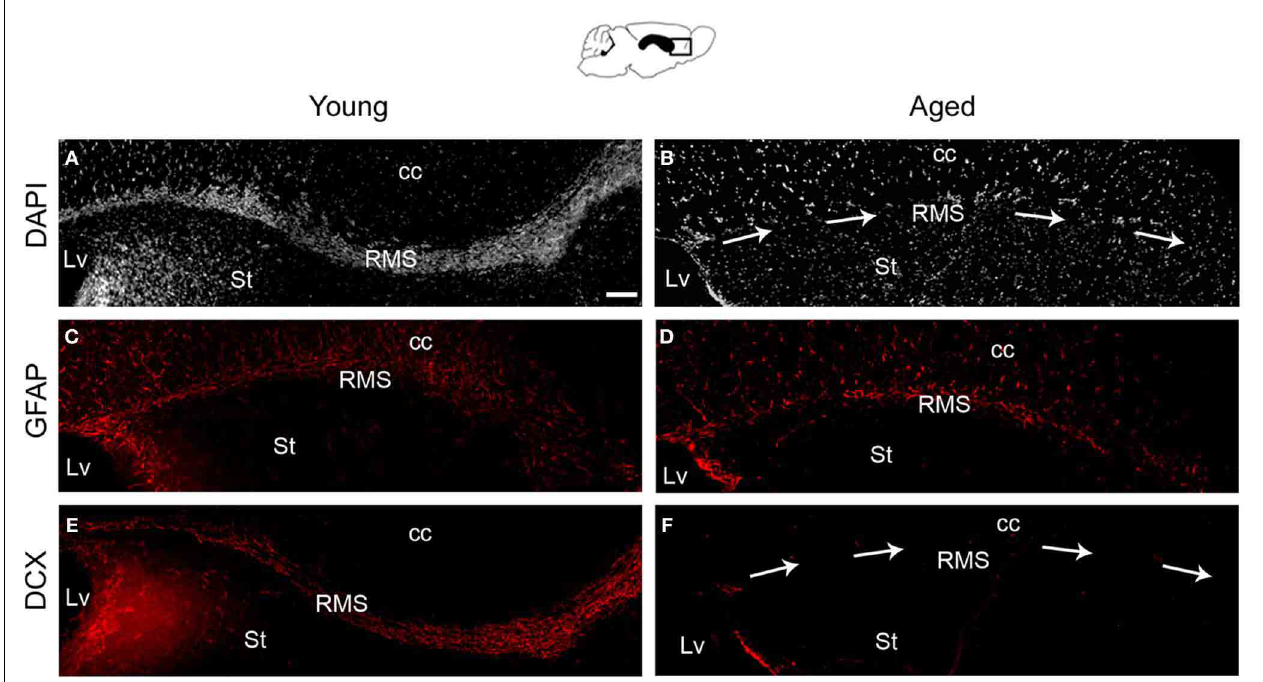
FIGURE 1 | The population of neuroblasts within the RMS is disrupted during aging. Sagittal sections of the RMS in young and aged mice. (A) Young RMS stained with DAPI. (B) Aged RMS stained with DAPI, showing a notable reduction of cells in the migratory pathway (arrows). (C) Young RMS immunolabeled with GFAP. (D) Aged